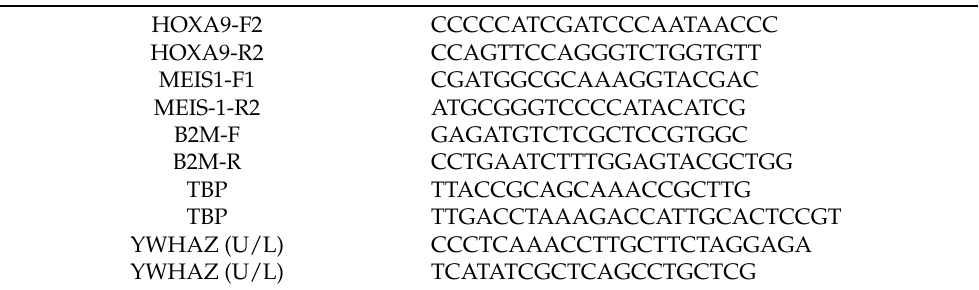
Supplementary Materials: The following are available online, Figure S1: Presentation of co-crystal ligand EPZ004777 (magenta) and best three re docked ligands in the active pocket ofDOT1L (left) and important amino acid residues included in interaction with co-crystal ligand (right), Figure S2: Western blot used for Figure 7, Figure S3: Cell cycle analysis of MV4-11 cells treated with 3-Dia-2 over time. Inhibition of cell cycle progress on MV4-11cells treated with compound Dia-2 at 1 µ M or 3.2 µ M and EPZ- 5676 at 1 µ M. Cells treated with an equal amount of DMSOwere used as negative controls. Cells were fixed with ethanol and stained with propidium iodide. Cell cycle distributionwas analyzed by a flow cytometry. One representative experiment is reported and its quantification, Figure S4: Cell apoptosis analysis of MV4-11 cells treated with 3-Dia-2 over time. Apoptosis ratio detection by